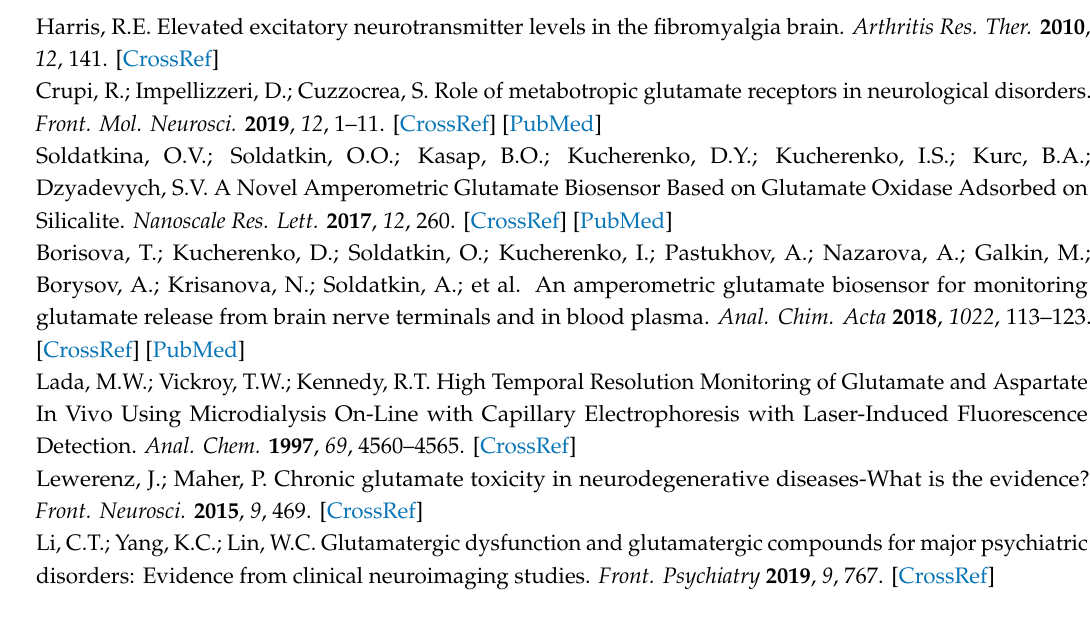
Figure S1: Calibration plots of two representative biosensors’ designs in a 21 days period of time Ptc / PPD / PEI(1%)2 / GlutOx5 / DEG(0.1%) (Panel A); Ptc / PPD / PEI(1%)2 / GlutOx5 / TEG(0.1%) (Panel B), Figure S2: SEM of di ff erent biosensors’ designs at 5000X (Panels A) and 10000X (Panels B)